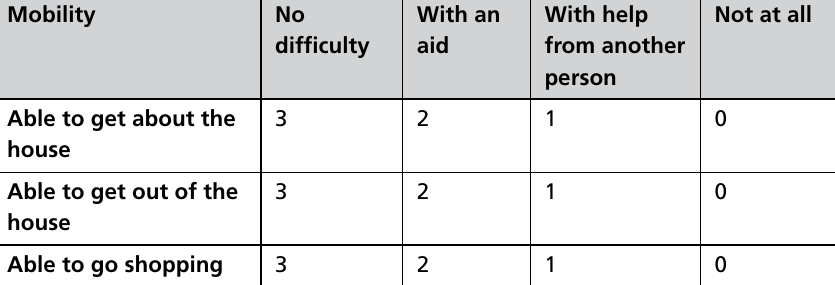
Figure 1: Follow-up of participants during the table 1: new Mobility score(nMs) (Palmer and Parker, 1993)